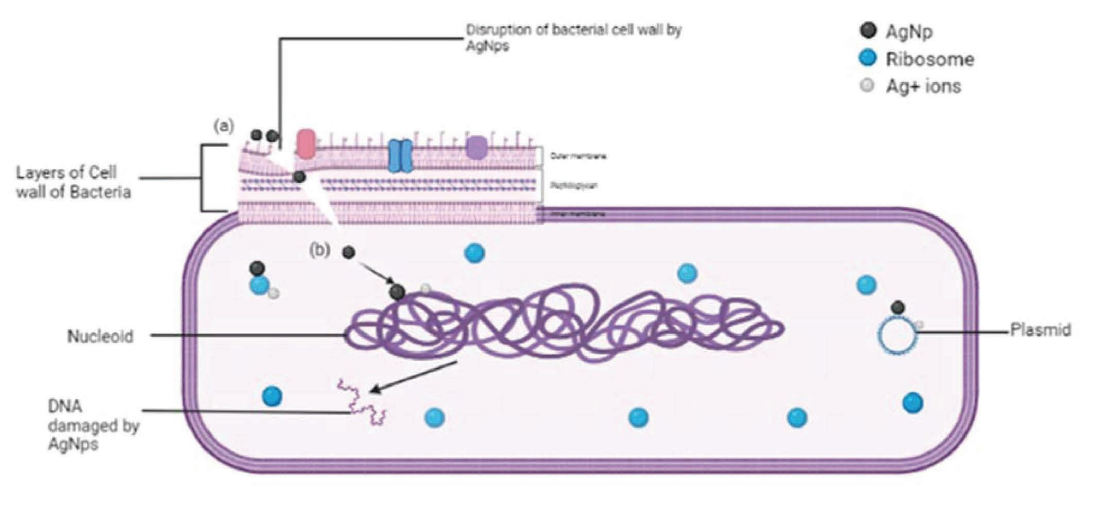
Figure 13: Te schematic diagram of the antibacterial activity of green synthesized